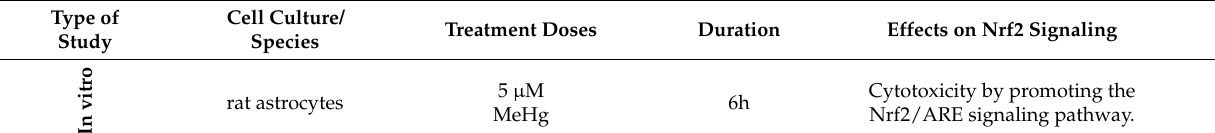
Table 4. Summary of studies analyzing the effects of Hg on Nrf2